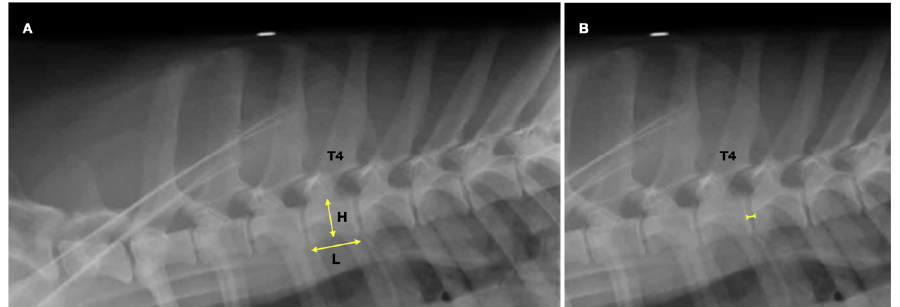
Figure 1. The measurement method of the fourth thoracic vertebral (T4) length and height ( A ) and the length of the fourth and the fifth intervertebral disc space ( B ) on the lateral thoracic radiograph.